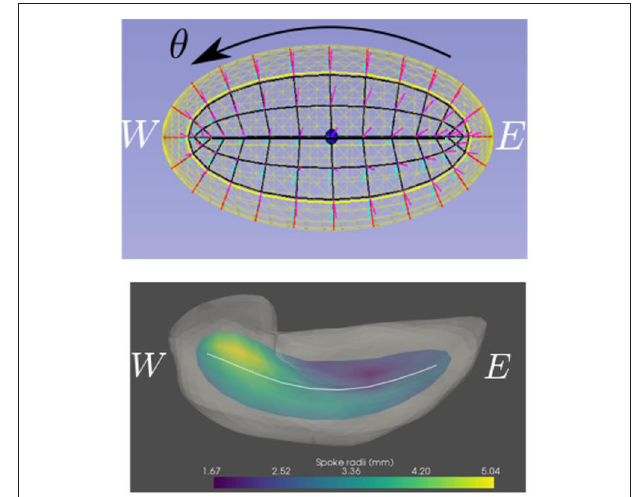
FIGURE 5 | Top: The three parameters for an ellipsoid, as seen from a direction called “north”. The bold line is its spine; the bullet is its center point; the inner yellow curve is the fold of the skeleton; θ goes around the elliptical and quasi-elliptical curves; τ 1 goes along the black, non-bold lines; τ 2 goes from the skeletal plane out to the ellipsoid boundary. Bottom: the skeleton and spine transferred to the